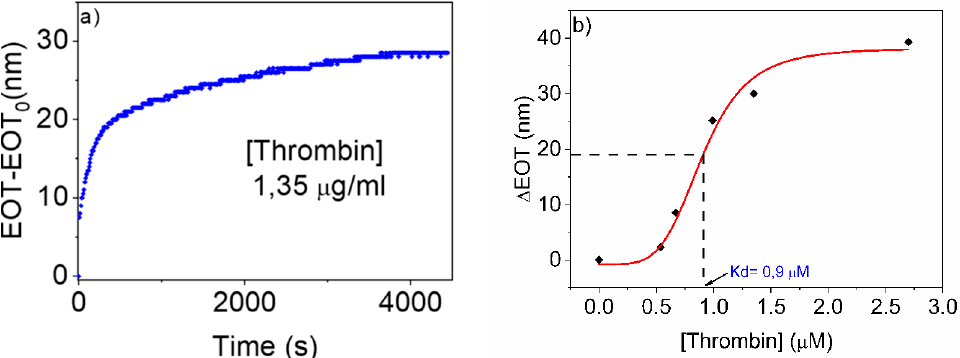
Figure 5. Study of thrombin detection. ( a ) Variation of EOT with time for one of the experiments performed for thrombin detection of 1.35 µM. ( b ) Absolute change in Δ EOT at different concentrations of thrombin. Red line represents a calibration curve by fitting with Boltzmann equation.